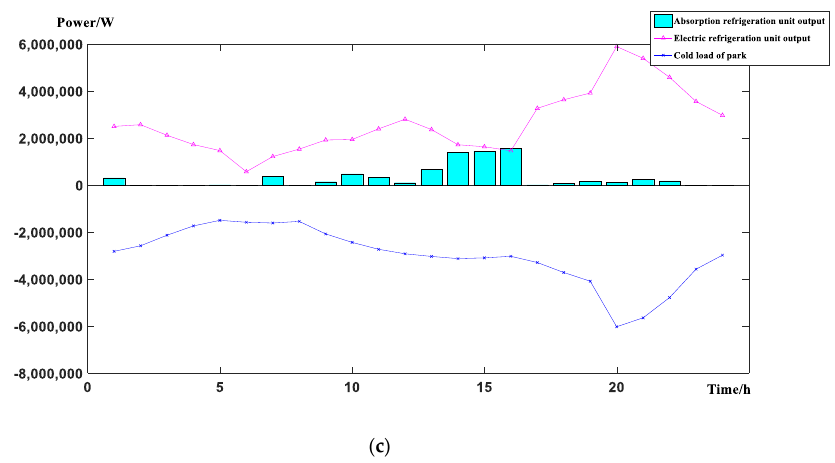
Figure 6. Optimal scheduling result of a zone. ( a ) Optimal scheduling result of electric load. ( b ) Optimal scheduling result of heat load. ( c ) Optimal scheduling result of cold load.